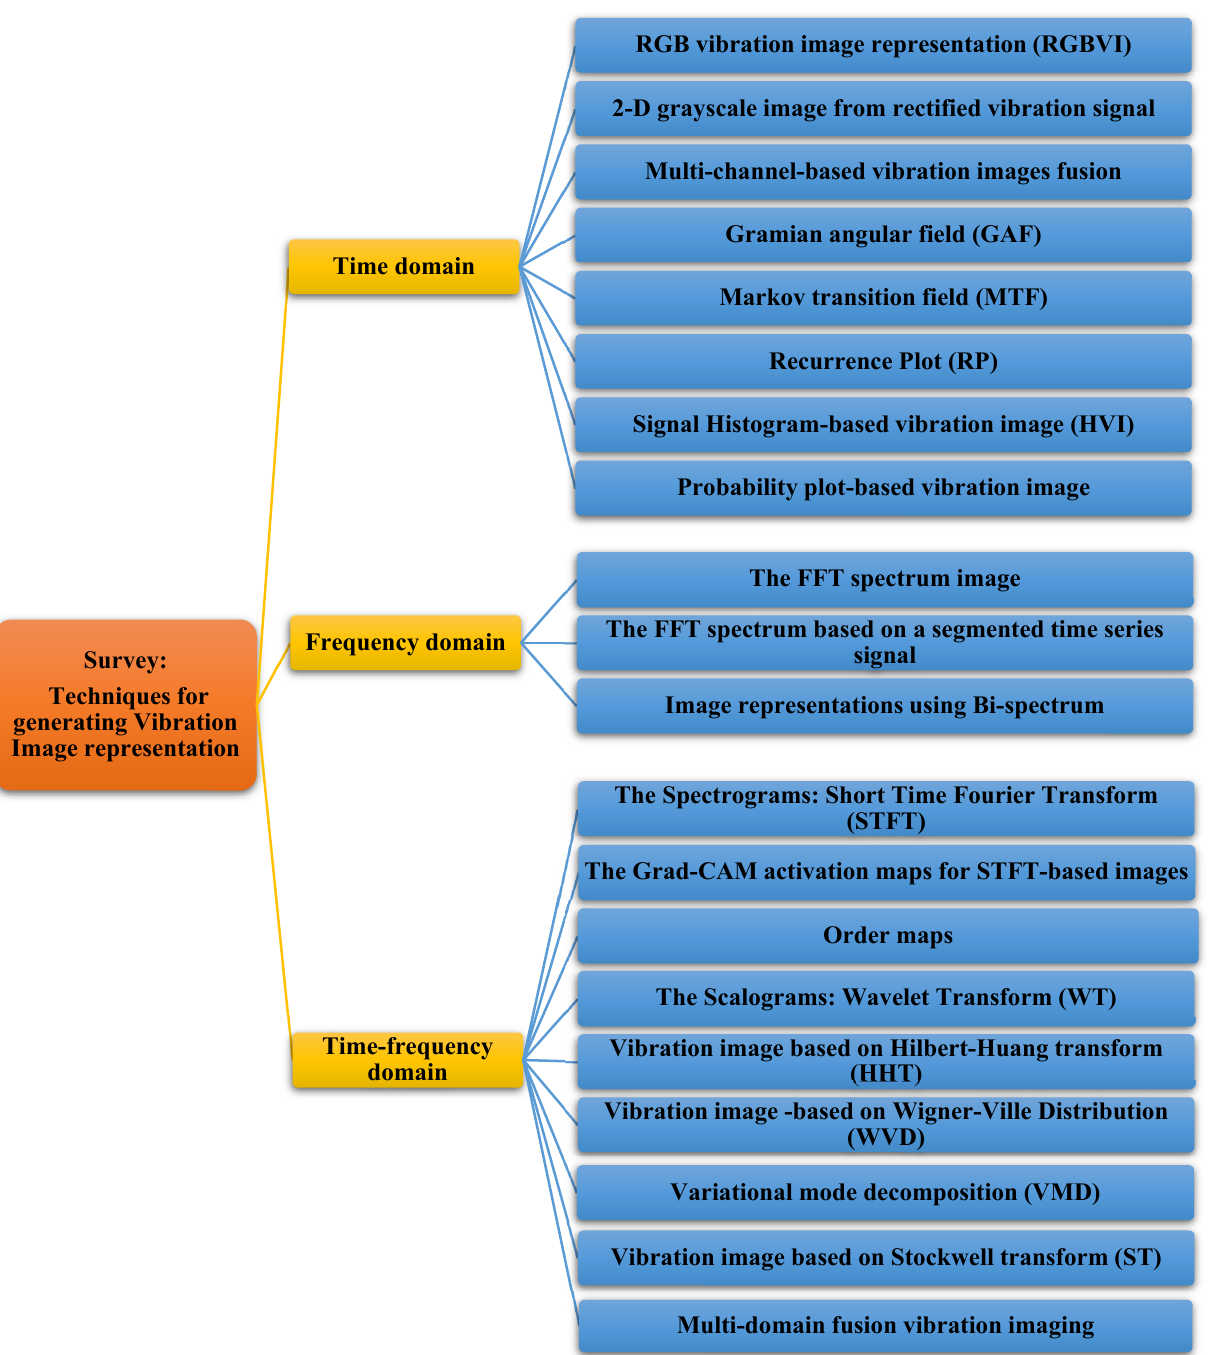
Figure 2. An overview of vibration image representation techniques.